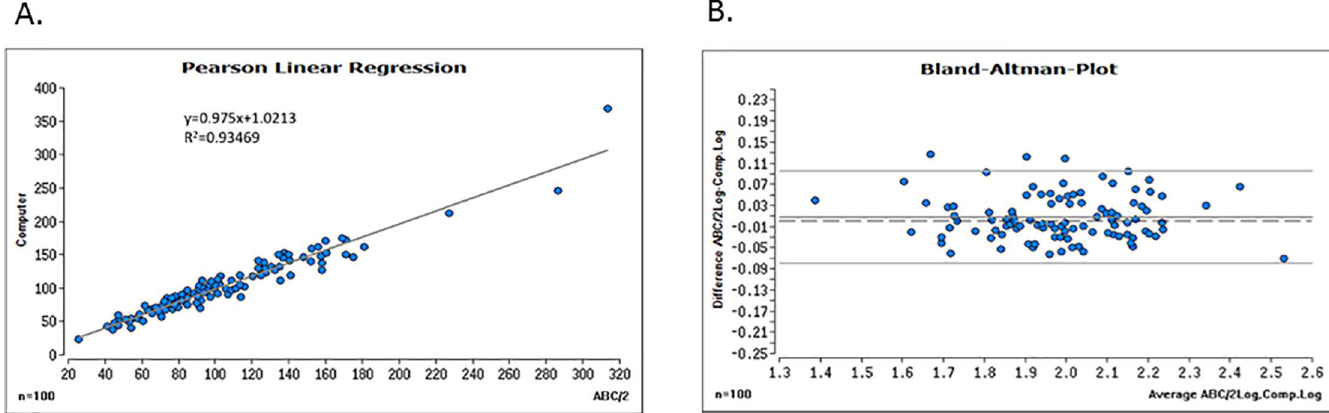
Fig 2. A. Pearson Linear regression analysis between ABC/2 and computer-assisted volumetric measurement. B. Bland-Altman regression analysis between log of ABC/ 2 and log of computer-assisted volumetric measurement.